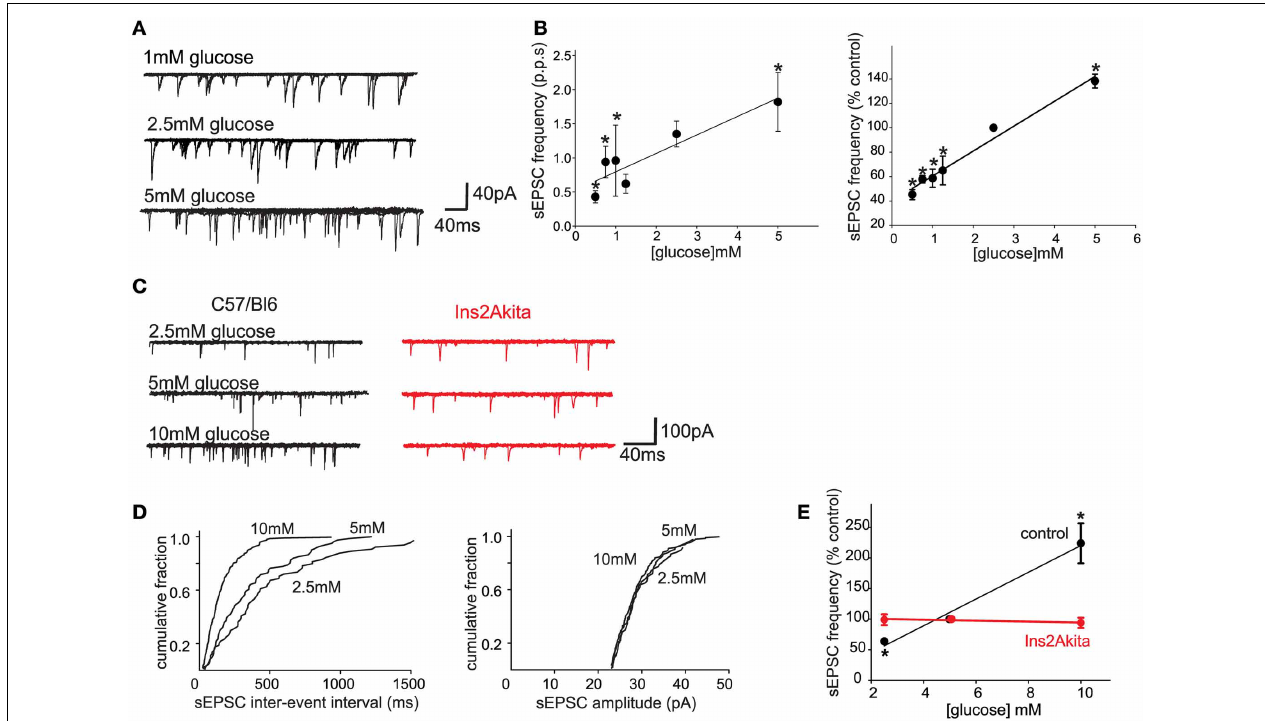
mouse and (b) altered during pathophysiological conditions such as diabetes, whole cell patch clamp recordings were made from NTS subnucleus centralis (cNTS) neurons ( n = 9) in control (C57/Bl6) mice as well as from neurons ( n = 8) in a mouse model of spontaneously developing Type 1 diabetes (Ins2Akita mice). As in the rat, the frequency of sEPSCs in cNTS neurons was dependent upon the extracellular glucose level in C57/Bl6 mice (left). In detail, in 5/6 neurons tested, decreasing the extracellular glucose concentration from 5 to 2.5mM decreased sEPSC frequency; in contrast, in 6/7 neurons tested, increasing the extracellular glucose concentration from 5 to 10mM increased sEPSC frequency. In no instance was any effect on sEPCS amplitude observed (113 ± 10% of control amplitude in 2.5mM glucose and 100 ± 6% of control amplitude in 10mM glucose; P > 0 . 05 in each case). In contrast, the ability of glucose to modulate the frequency of sEPSCs was lost in neurons from Ins2Akita mice (right). In detail, 4/5 neurons tested, decreasing the extracellular glucose concentration from 5 to 2.5mM had no effect on sEPSC frequency while increasing extracellular glucose concentration from 5 to 10mM had no effect on sEPSC frequency in any of the 5 neurons tested. (D) Computer generated graphics from the same control C57/Bl6 neuron as above showing that glucose increases the frequency (left) but not amplitude (right) of sEPSCs suggesting that, as in the rat, glucose acts at presynaptic sites to modulate glutamate release. (E) Summary graphic illustrating the relationship between extracellular glucose level and frequency of sEPSCs in cNTS neurons from control C57/Bl6 and diabetic Ins2Akita mice. When expressed a percentage of frequency at control glucose level (5mM glucose), the ability of glucose to modulate the frequency of sEPSCs was lost in diabetes. ∗ P < 0 . 05 vs. control